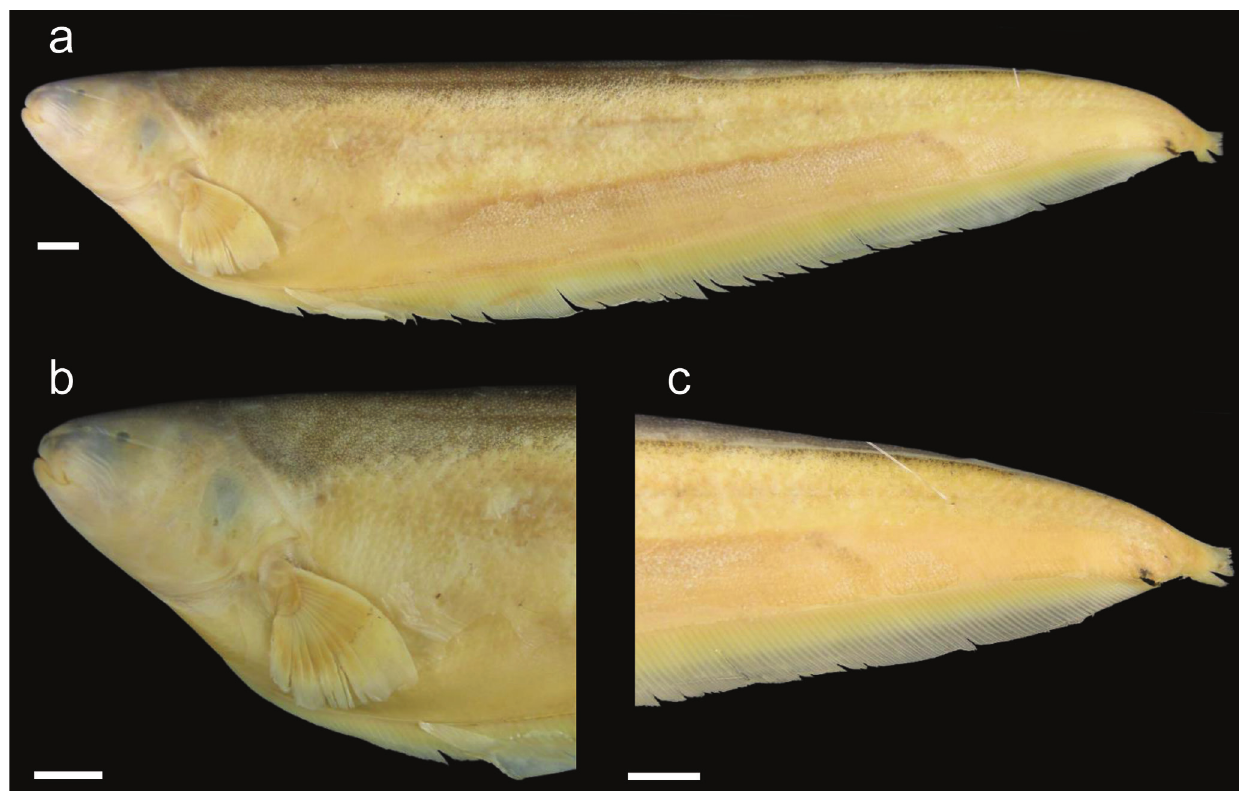
Fig. 11. Sternarchella rex (ANSP 200294). a. Lateral view of the body, b. Lateral view of the head, c. Lateral view of the caudal region. Scale bars = 1.5